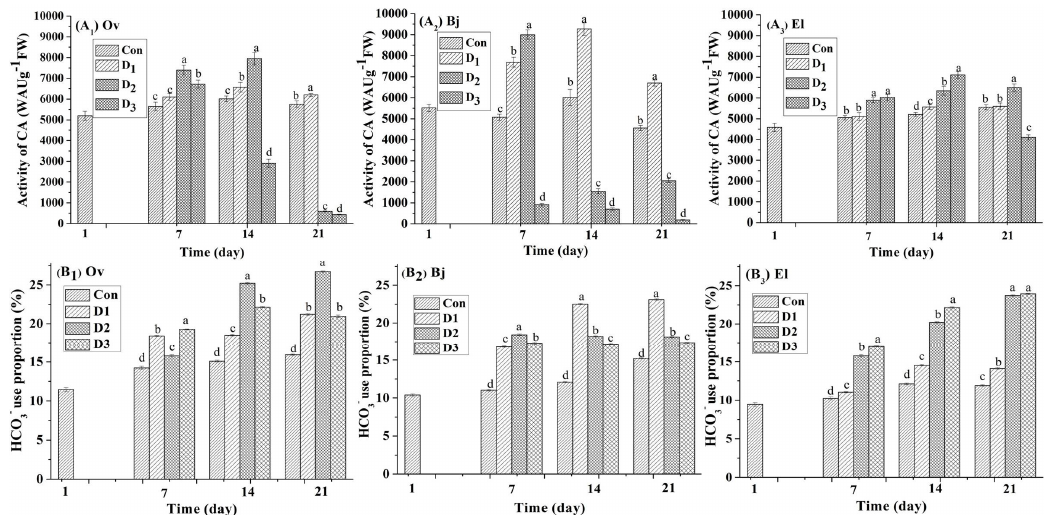
Figure 3. Effect of different levels (Con: 25% moisture, D 1 : 17% moisture, D 2 : 14% moisture, and D 3 : 11% moisture) of drought stress on CA activity (WAU g − 1 (FW)) and proportion of HCO 3 − use in the leaves of three plant species. Different letters above the bars represent significant differences amongst treatments on the same day ( p < 0.05). ( A 1 -A 3 ) CA activity (WAU g − 1 (FW)) of Orychophragmus violaceus L. (Ov), Brassica juncea L., and Euphorbia lathyris L. (EL); ( B 1 -B 3 ) HCO 3 − use proportion of Orychophragmus violaceus L. (Ov), Brassica juncea L., and Euphorbia lathyris L. (EL).